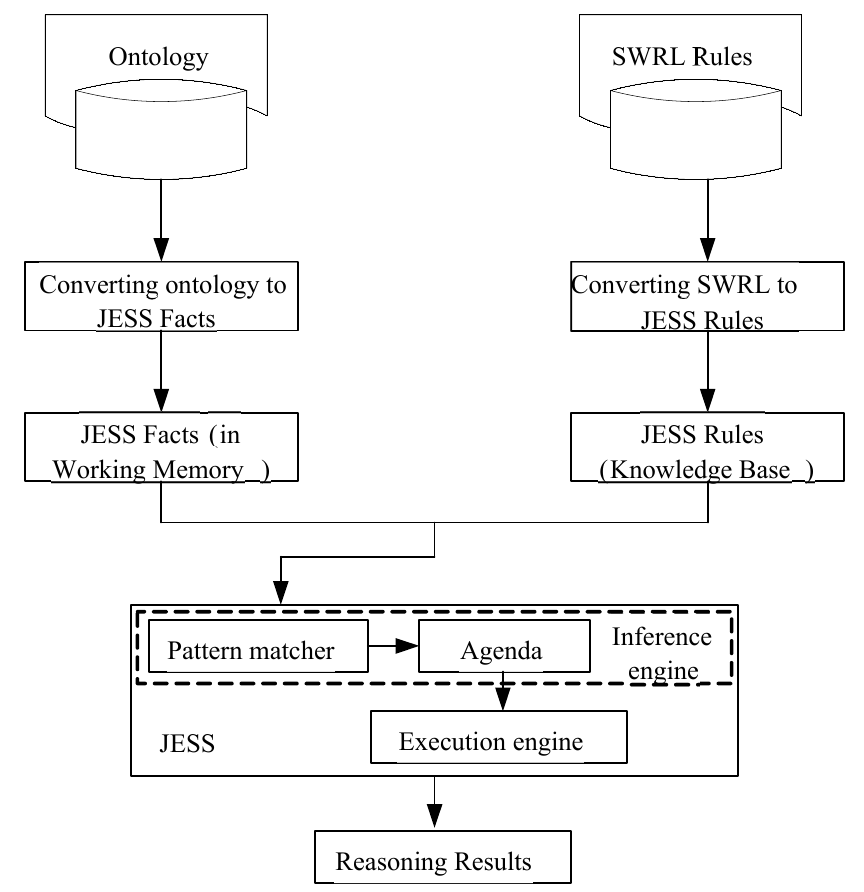
Figure 10. The reasoning processes.